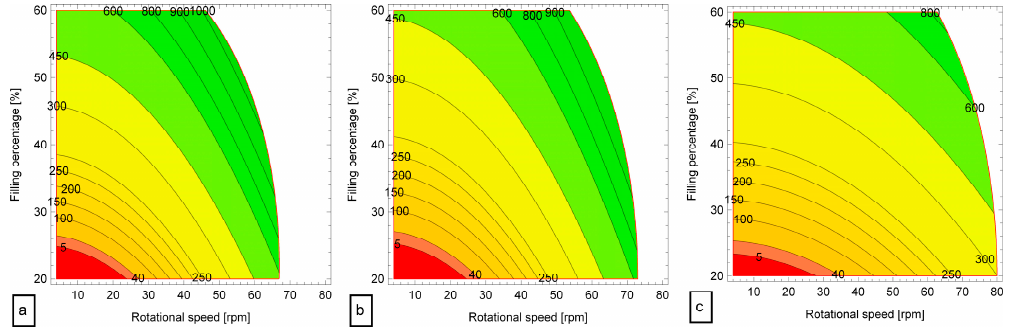
Figure 5. Ba at di ff erent processing parameters for charge 1 ( a ), charge 2 ( b ), and charge 3 ( c ).